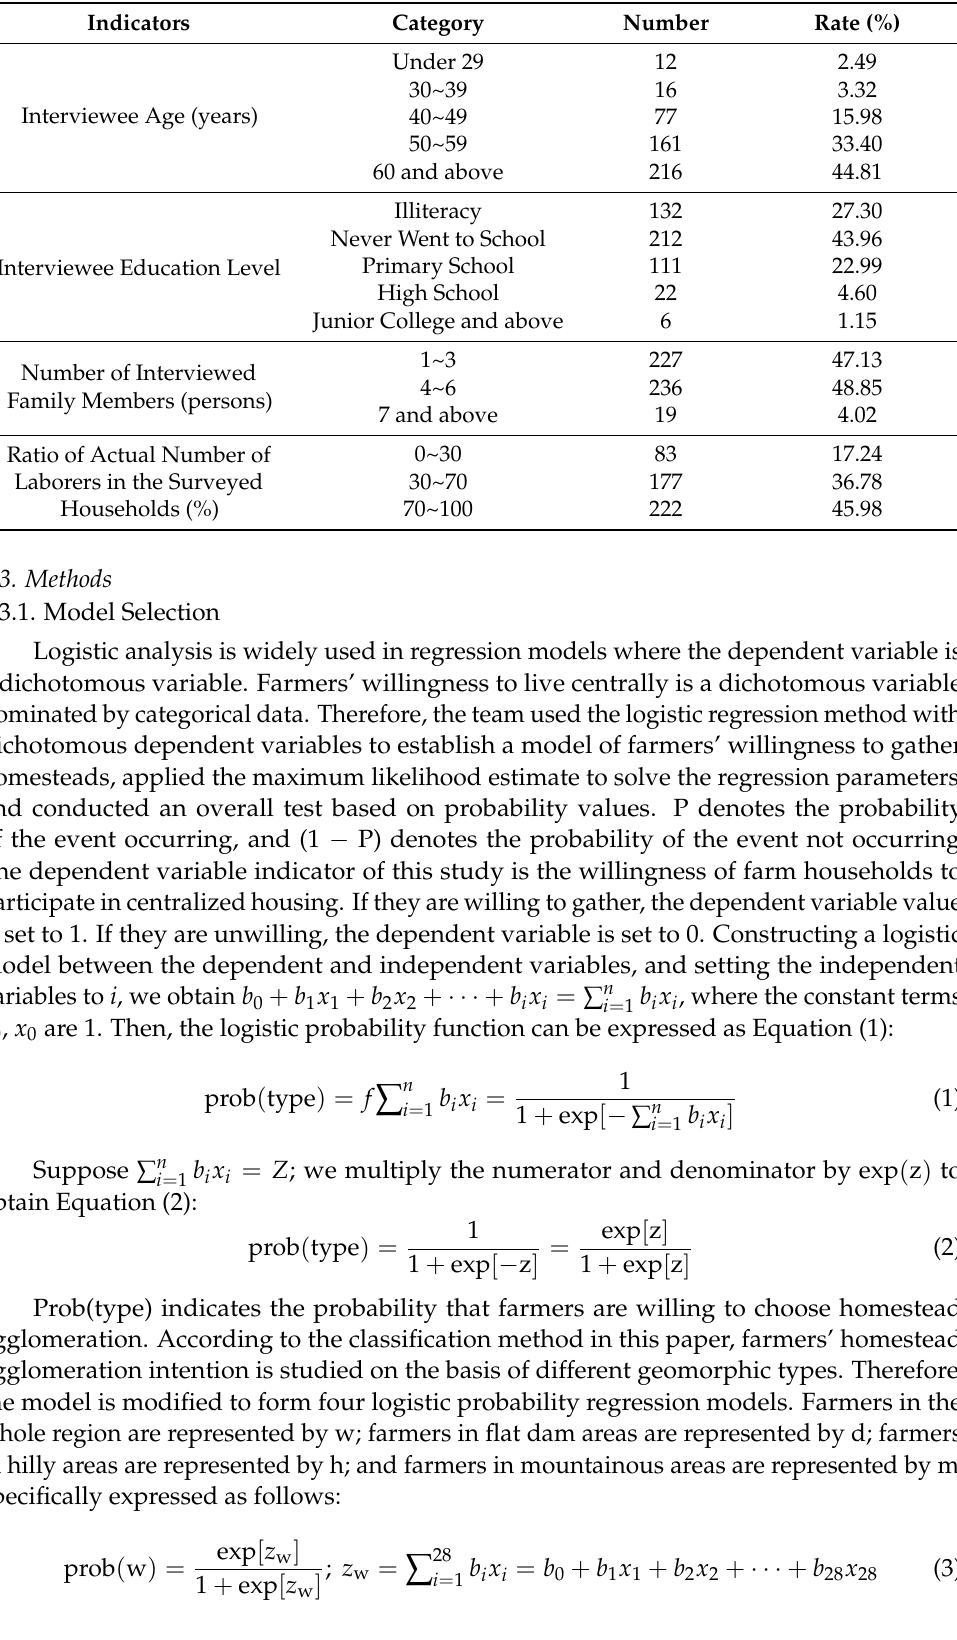
Table 2. Characteristic distribution of farmer